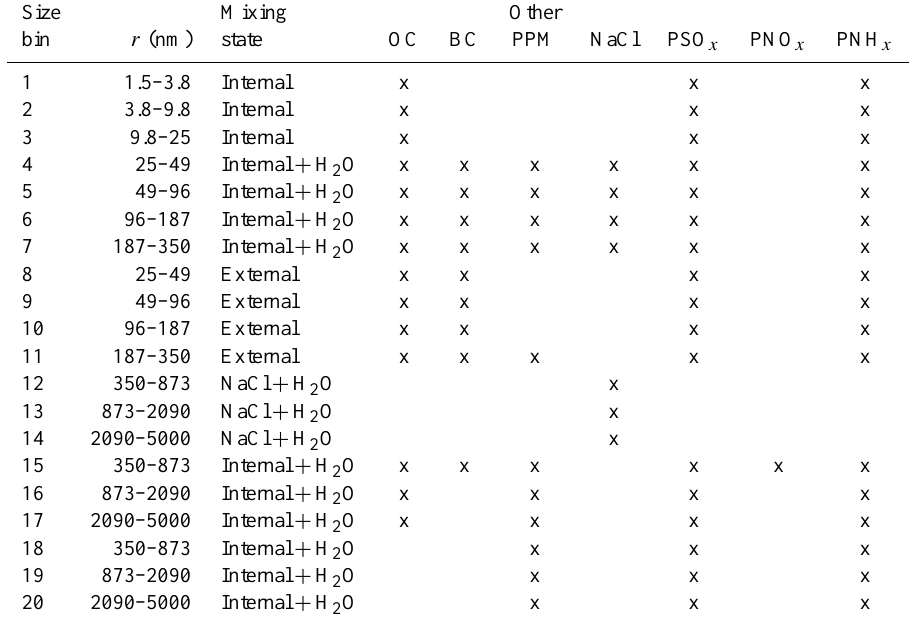
Table 2. Size bins and chemical species in the MATCH-SALSA aerosol microphysical transport model. An “x” marks that the species is present in a particular size